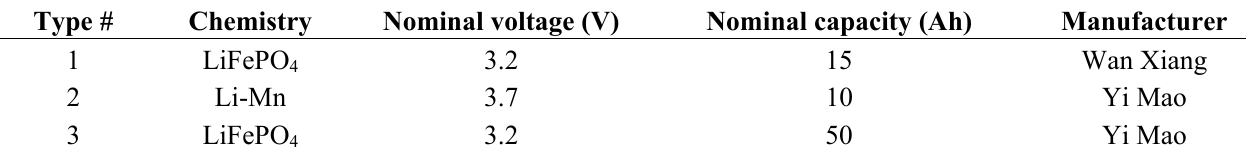
Table 2. Tested types of Li-ion